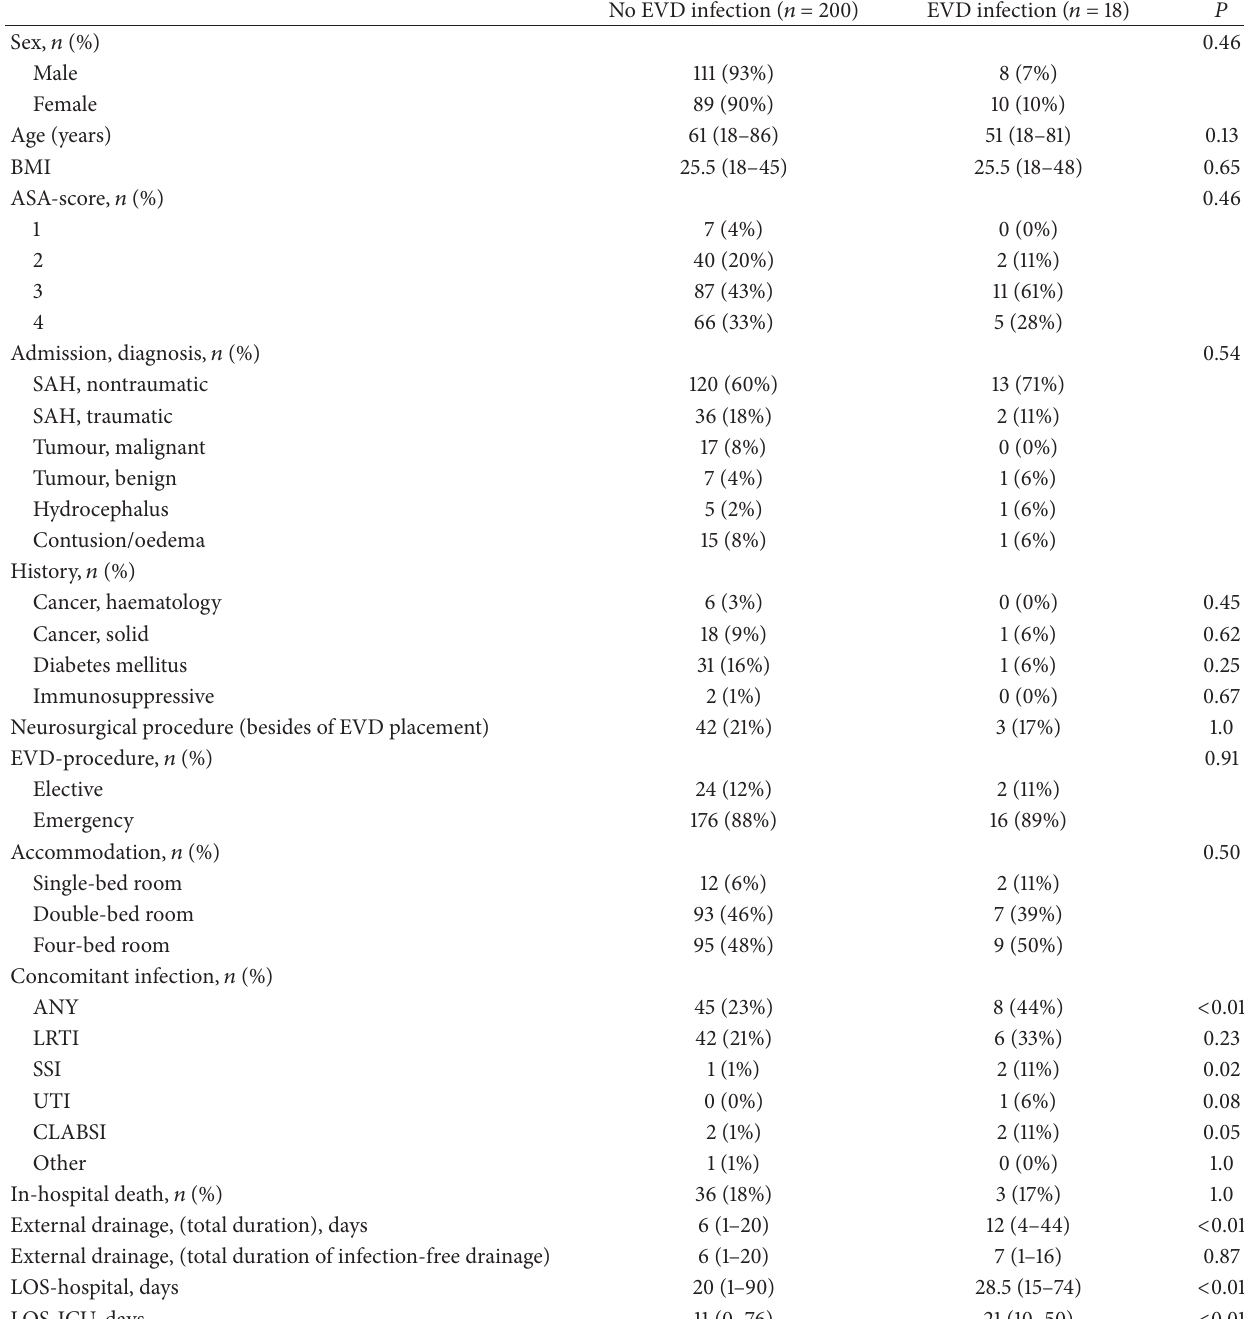
Table 3: Patient demographics and outcome of EVD-related